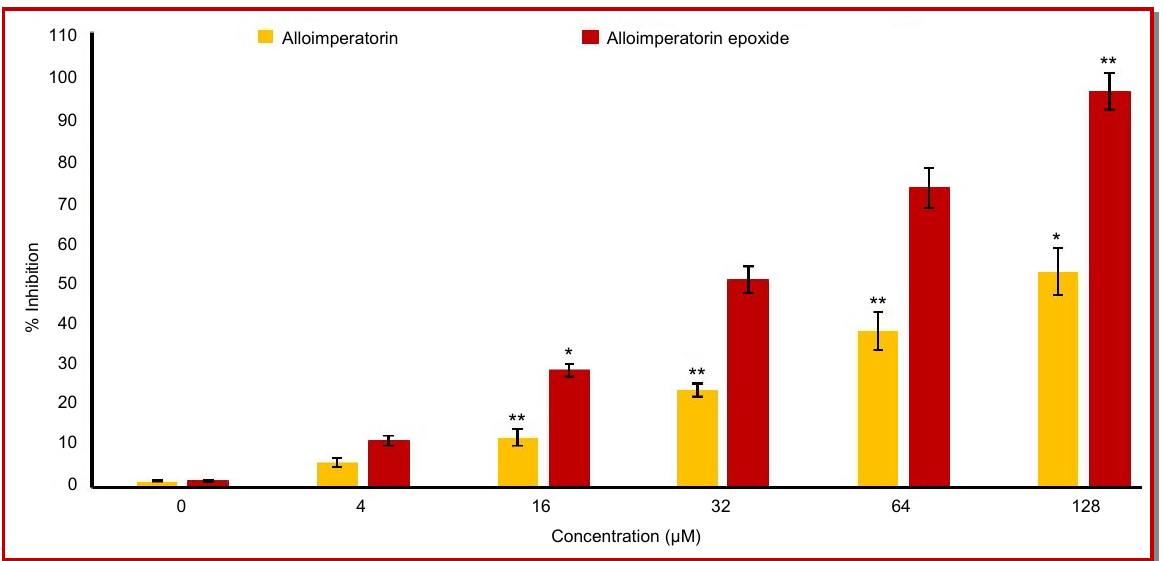
Figure 1: Synthetic procedure for the synthesis of epoxide derivative of alloimperatorin using m-chloroperbenzoic acid in di- chloromethane